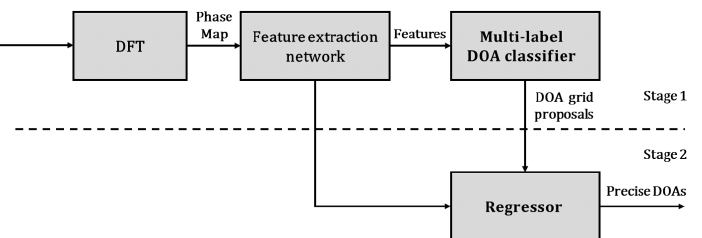
Figure 1. Block diagram of the proposed off-grid direction of arrival (DOA)